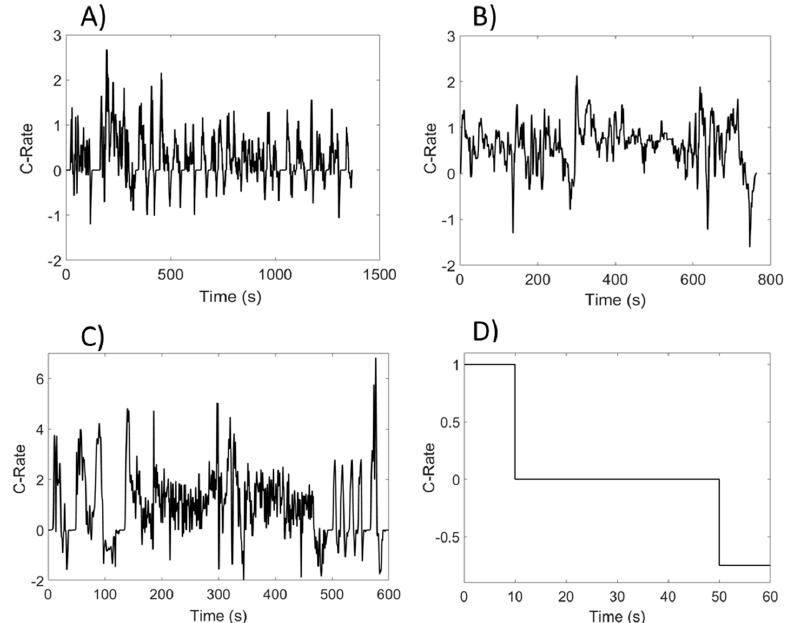
Figure 2. ( A ) Urban Dynamometer Driving Schedule, ( B ) Highway Fuel Economy Test ( C ) US06 and ( D ) HPPC current profile used in validating the resistance estimation algorithms.